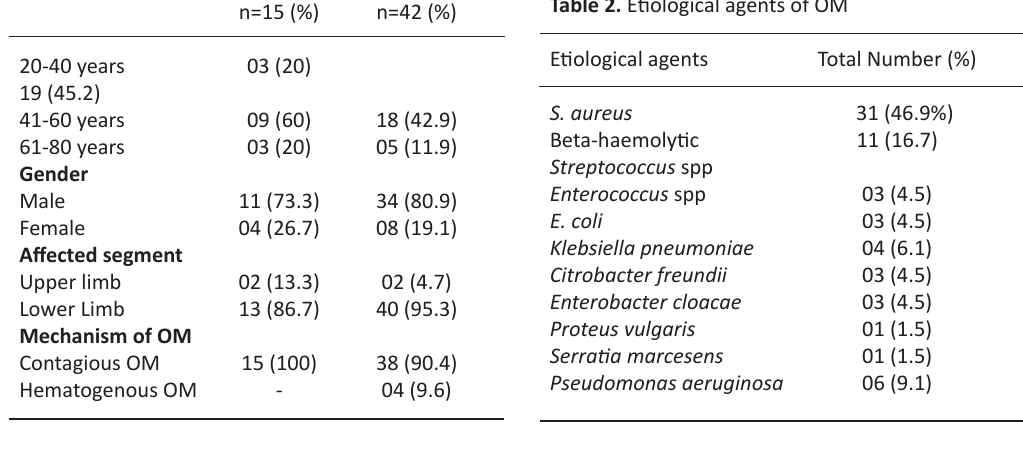
Table 3. Antibiotic susceptibility of Gram positive bacteria [Number (%) of sensitive strain] Antibiotics